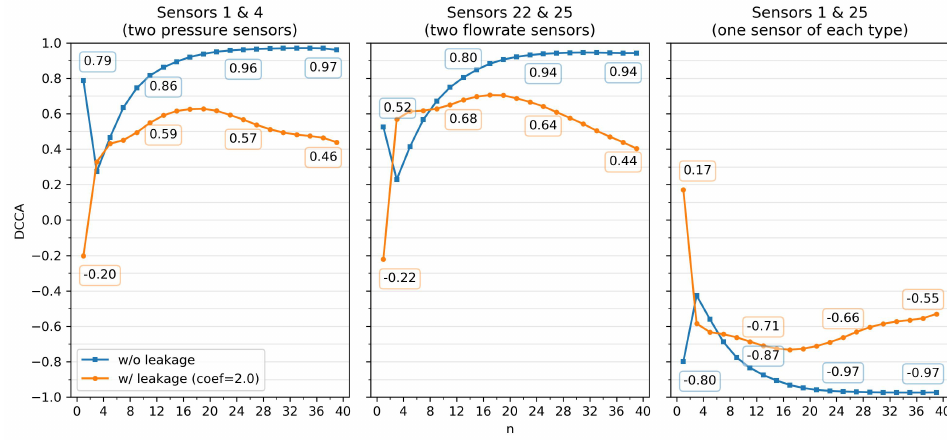
Figure 15. Impact of parameter n on DCCA in three selected pairs from chunk 702 using a time window of 40 time points.